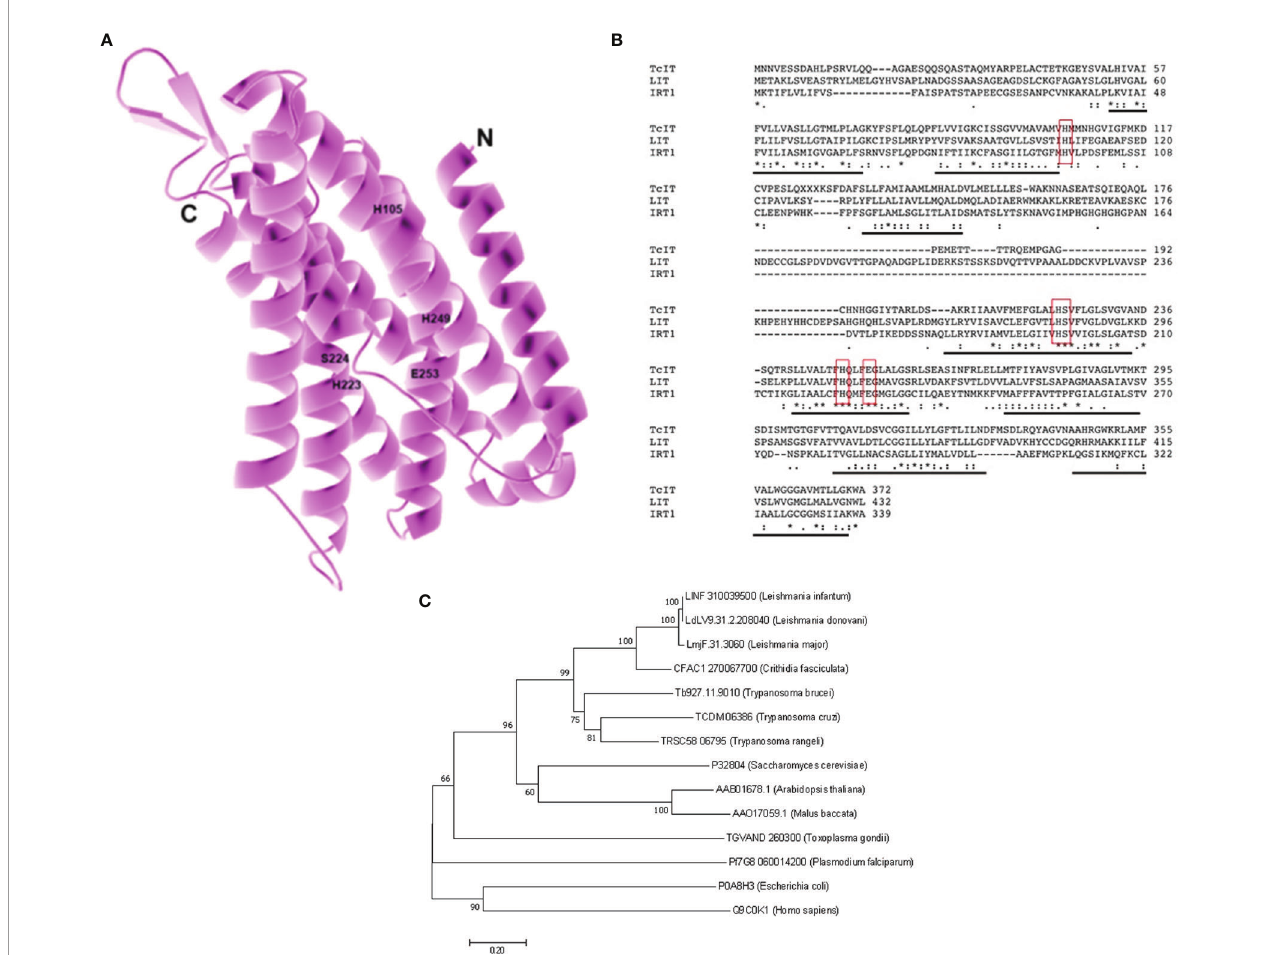
FIGURE 1 | Model for the iron (Fe) transporter TcIT: alignment and phylogenetic analysis for TcIT and ZIP family members from different species. (A) Structural model of Fe transporter from T. cruzi (TcIT). The model was constructed using the protein structure prediction PHYRE (www.sbg.bio.ic.ac.uk/phyre/) (Kelley and Sternberg, 2009) and visualized with the standard molecular viewer PyMOL 2002 (PyMOL Molecular Graphics System, DeLano Scienti fi c, San Carlos, CA, USA; http://pymol.sourceforge.net/). The eight transmembrane helices are shown in pink, and labels highlight the fi ve key residues mentioned in the text. (B) Alignment of amino-acid sequences from T. cruzi TcIT, DM28c strain (TriTryDB: TCDM_06386), L. major LIT1 (TritrypDB: LmjF.31.3060), and Arabidopsis thaliana IRT1 (GenBank: AAB01678.1). Conserved residues responsible for Fe transport in IRT1 and LIT1 (Jacques et al., 2010) are indicated in red boxes. Predicted transmembrane domains are underlined in black. Alignment used the ClustalW algorithm. Identical amino acids are indicated with an asterisk (*). Conservation between amino acid groups of strongly similar properties is indicated by a colon (:). Conservation between amino acid groups of weakly similar properties is indicated by a period (.). (C) Evolutionary relationships of ZIP family members. The evolutionary history was inferred using the neighbor-joining method (Saitou and Nei, 1987). The optimal tree with the sum of branch length = 6.09506879 is shown. The percentage of replicate trees in which the associated taxa clustered together in the bootstrap test (1,000 replicates) is shown at the beginning of each branch (Felsenstein, 1985). The tree is drawn to scale, with branch lengths in the same units as those of the evolutionary distances used to infer the phylogenetic tree. The evolutionary distances were computed using the Poisson correction method and given in the units of the number of amino-acid substitutions per site. All positions containing gaps and missing data have been eliminated. Evolutionary analyses were conducted in MEGA7 (Kumar et al., 2016), which involved 14 amino-acid sequences: Leishmania infantum putative sequence (GenBank: LINF310039500), L. donovani putative sequence (GenBank: LdLV9.31.2.208040), L. major LIT1 (GenBank: LmjF.31.3060), Crithidia fasciculata putative sequence (GenBank: CFAC1 270067700), Trypanosoma brucei putative sequence (GenBank: Tb927.11.9010), T. cruzi TcIT (GenBank: TCDM06386, this work), T. rangeli putative sequence (GenBank: TRSC58 06795), Saccharomyces cerevisiae ZRT1 (GenBank: P32804), Arabidopsis thaliana IRT1 (GenBank: AAB01678.1), Malus baccata MbIRT1 (GenBank: AAO17059.1), Toxoplasma gondii putative sequence (GenBank: TGVAND 260300), Plasmodium falciparum (GenBank: PfG8 0600 14200), Escherichia coli ZupT (GenBank: P0A8H3), and Homo sapiens SLC39A8 HsZIP8 (GenBank: